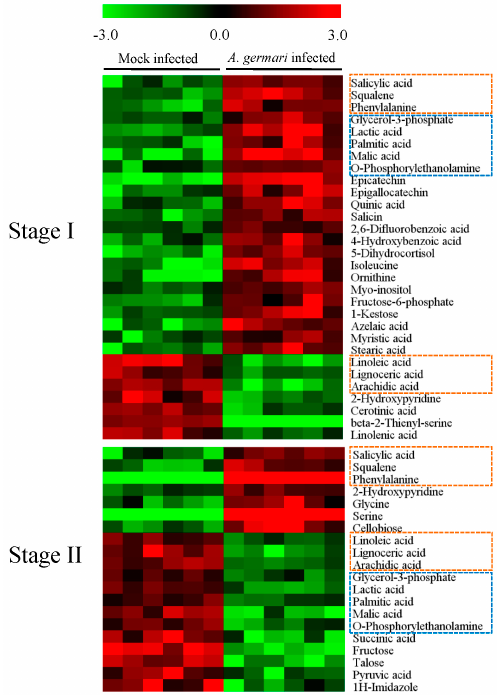
Figure 2. Differential metabolites associated with A. germari infection in bark tissues. Black bars denoted the sample classes. The columns and rows represented the individual tissue samples and distinct metabolites, respectively. The elevated and decreased levels of a metabolite were showed by increases in the intensities of red and green, respectively. Metabolites which appeared in both stages were marked with boxes. The orange and blue boxes marked metabolites showed similar and opposite changes between stage I and II,